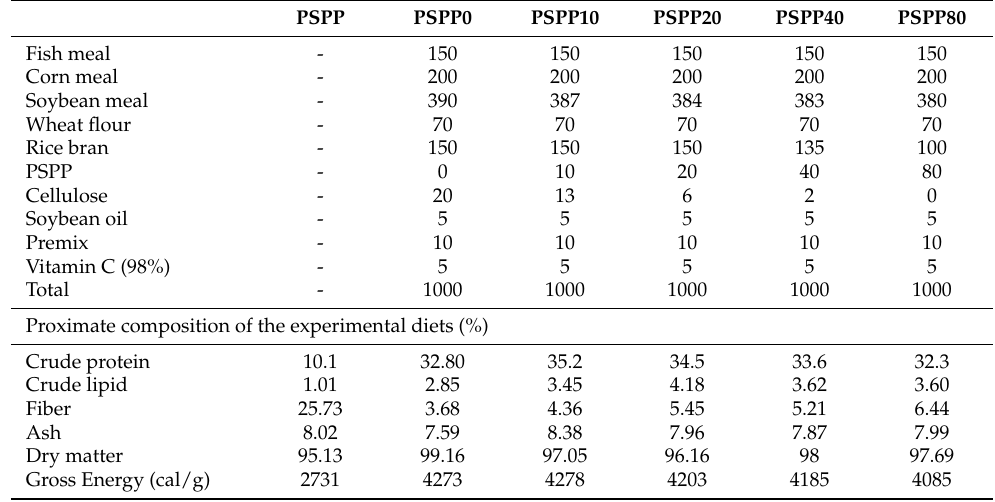
Table 1. Formulation and proximate composition of the experimental diets (g kg − 1